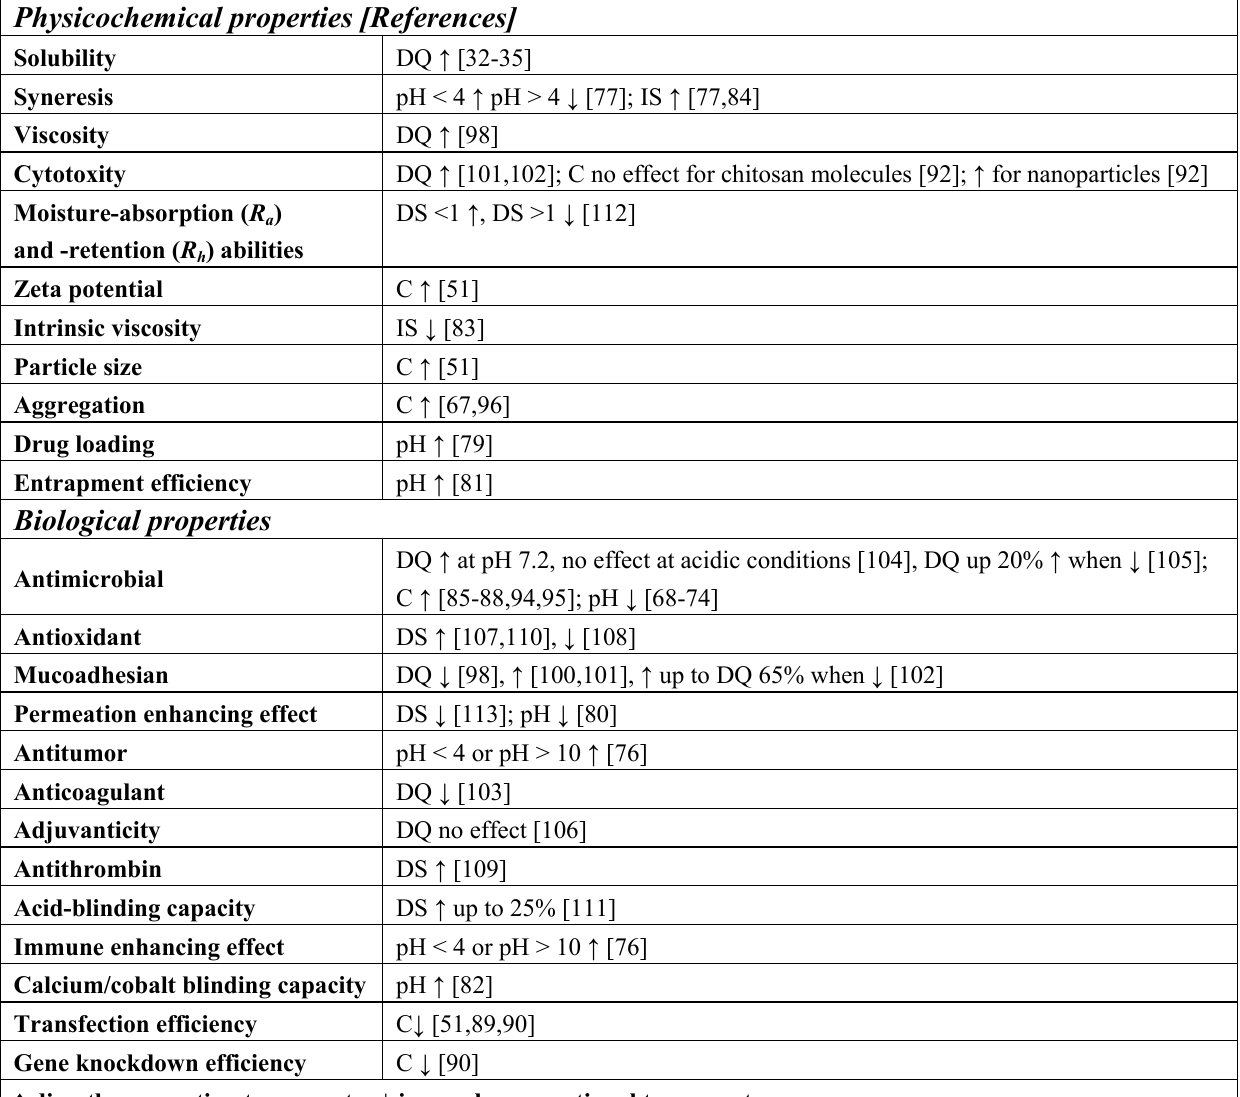
Table 1. Influence of selected key factors mentioned in the text on the physicochemical and biological properties of chitin/chitosan samples (DS—degree of substitution, DQ—degree of quaternization, IS—ionic strength, C—concentration,